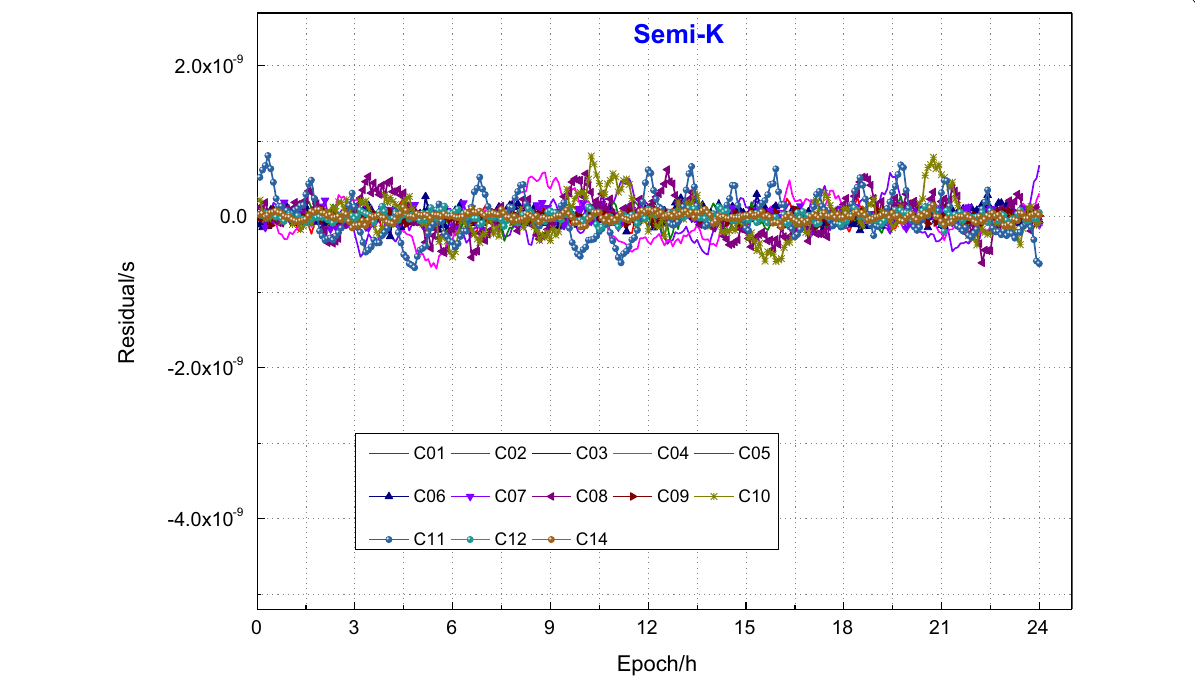
Fig. 3 Fitting residual sequence of Semi-K model